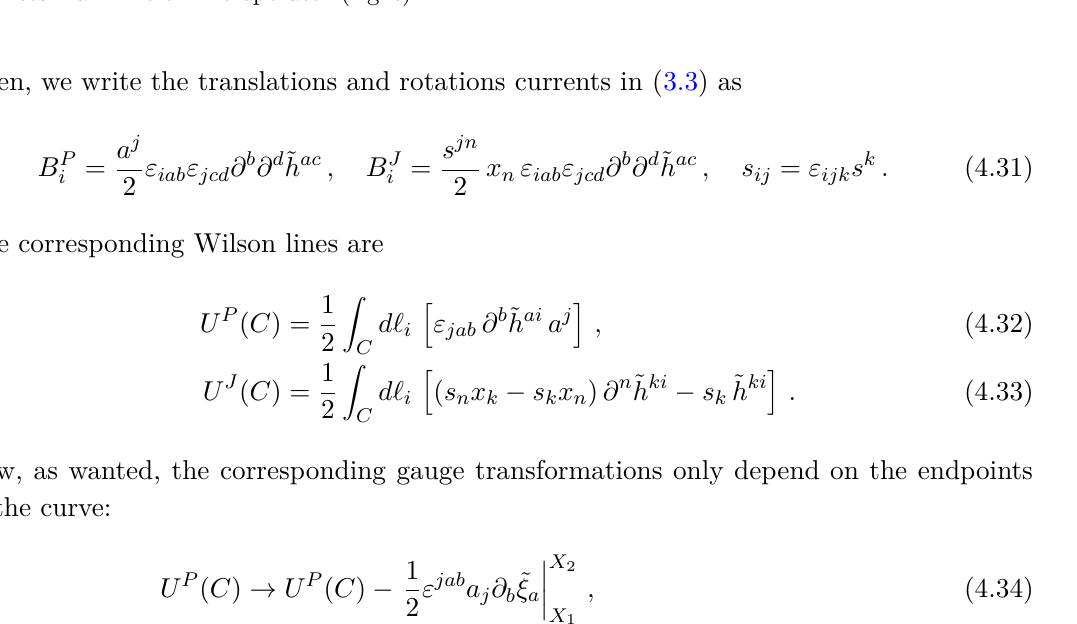
Figure 5 . Setup of the curves corresponding to a finite Wilson strip (left) and the associated infinitesimal limit or line operator